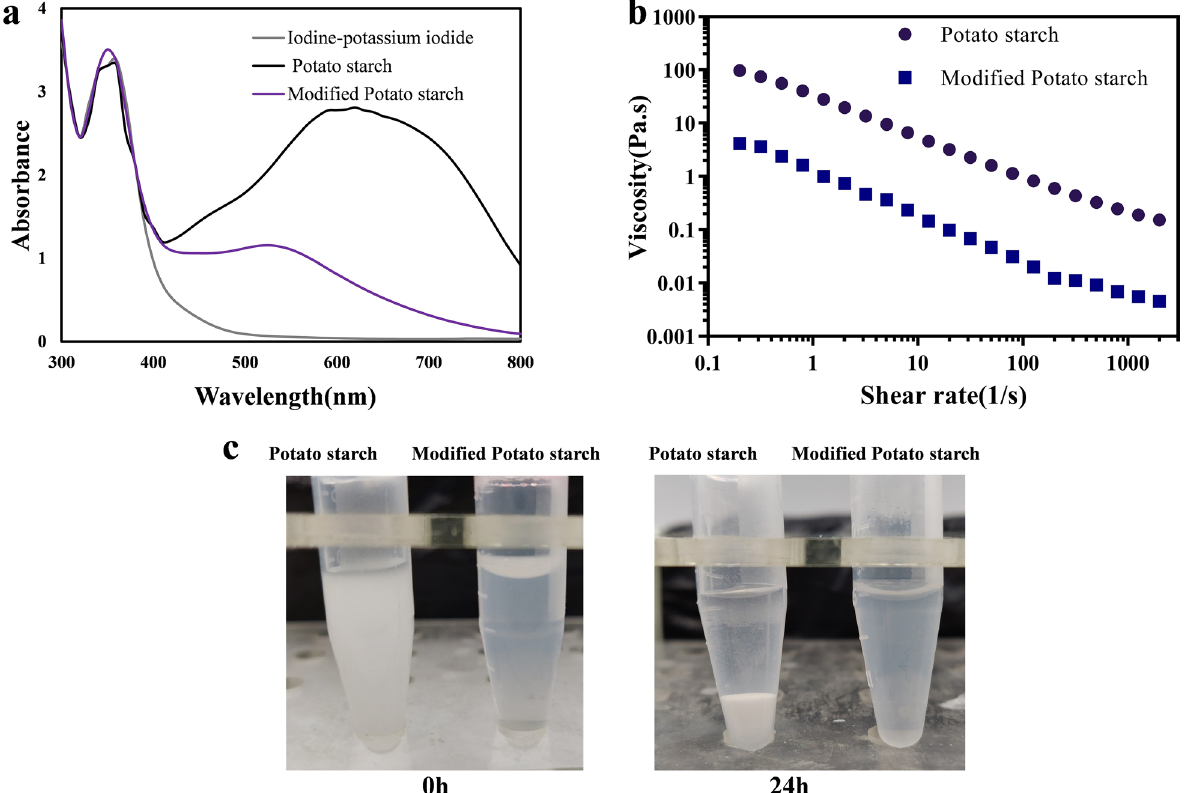
Fig. 5 Physicochemical characteristics of native and bl-GBE-modified potato starch a Wavelength scanning profile of iodine complex formed by starch, b Static rheological properties of bl-GBE modified potato starch, c Native and bl-GBE modified potato starch dissolution stability at different times (0 h, 24 h)